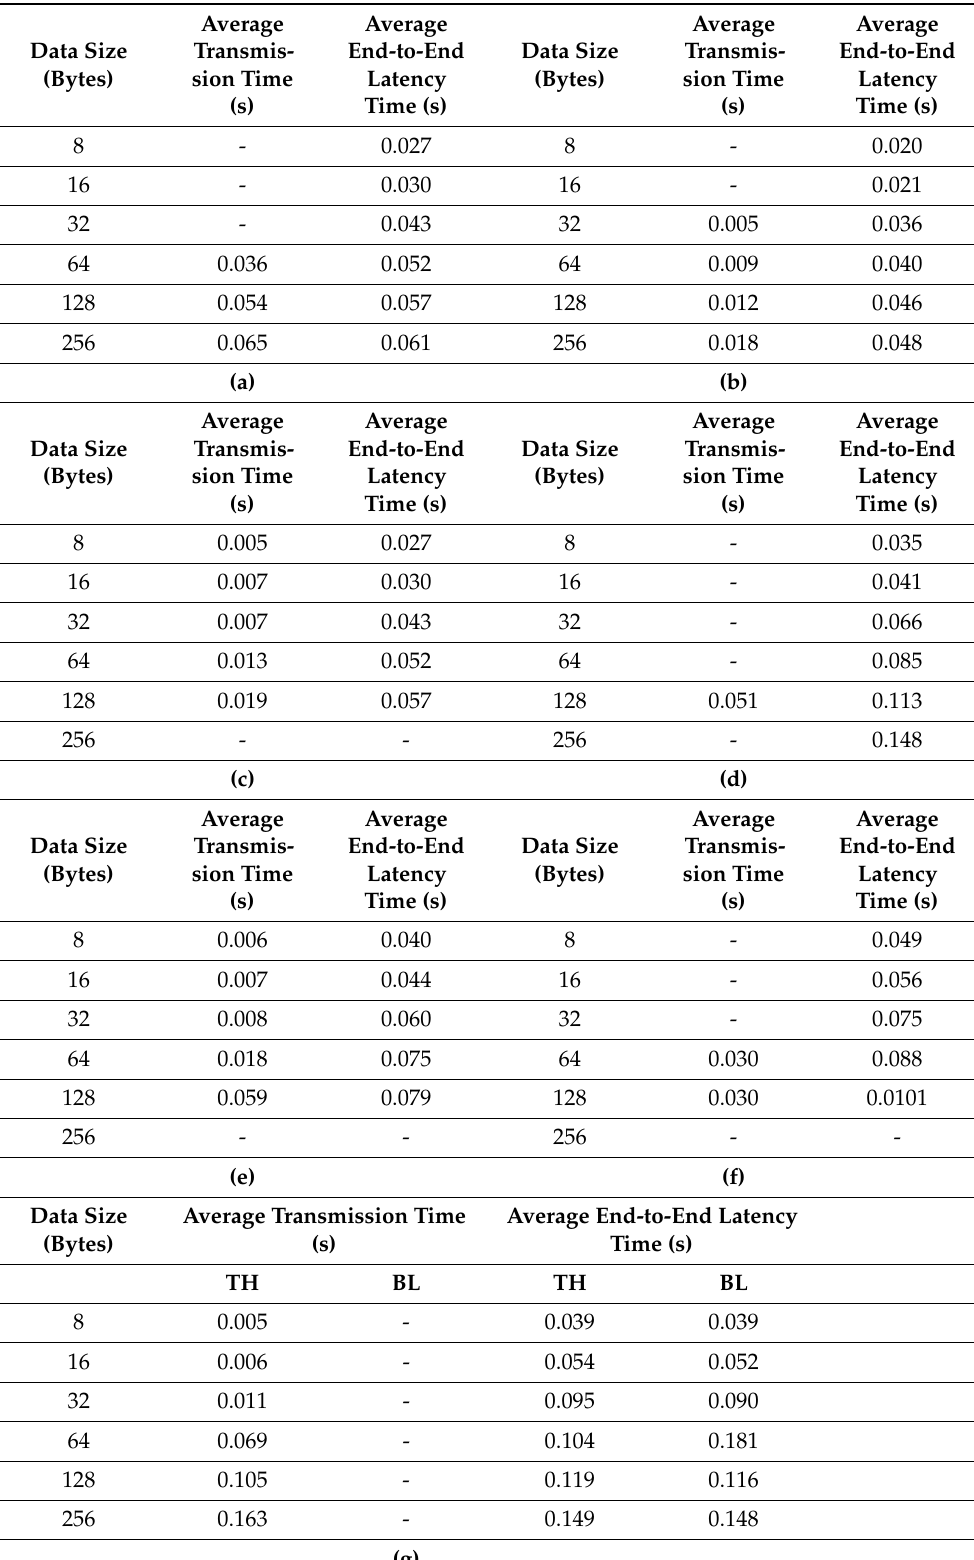
Table 3. The values for Average Transmission Time and Average End-To-End Latency Time for each connection pair: ( a ) Zigbee to Zigbee; ( b ) Bluetooth to Bluetooth; ( c ) Thread to Thread; ( d ) Zigbee to Bluetooth; ( e ) Zigbee to Thread; ( f ) Thread to Zigbee; ( g ) Zigbee to all—Mesh broadcast (20 m range with wall